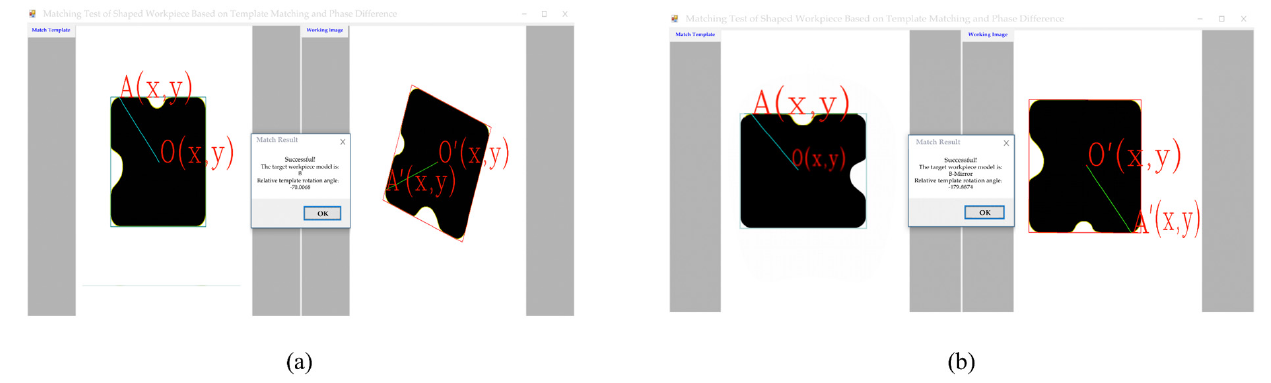
Figure 8. Target workpiece phase difference match. ( a ) −18° Rotation of the KB-Left; ( b ) 22°rota- tion of the KB-Right; ( c ) 180°rotation of the ZD631; ( d ) 90°rotation of the ZD632.